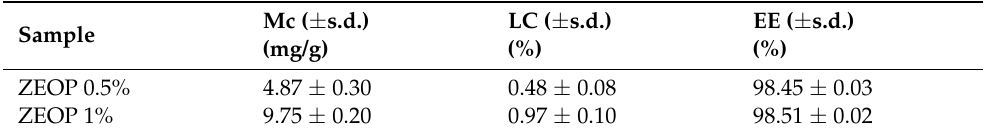
Table 2. ZEO content incorporated in ZEOP matrices per mass unit of sample (Mc), loading capacity (LC), and encapsulation efficiency (EE).